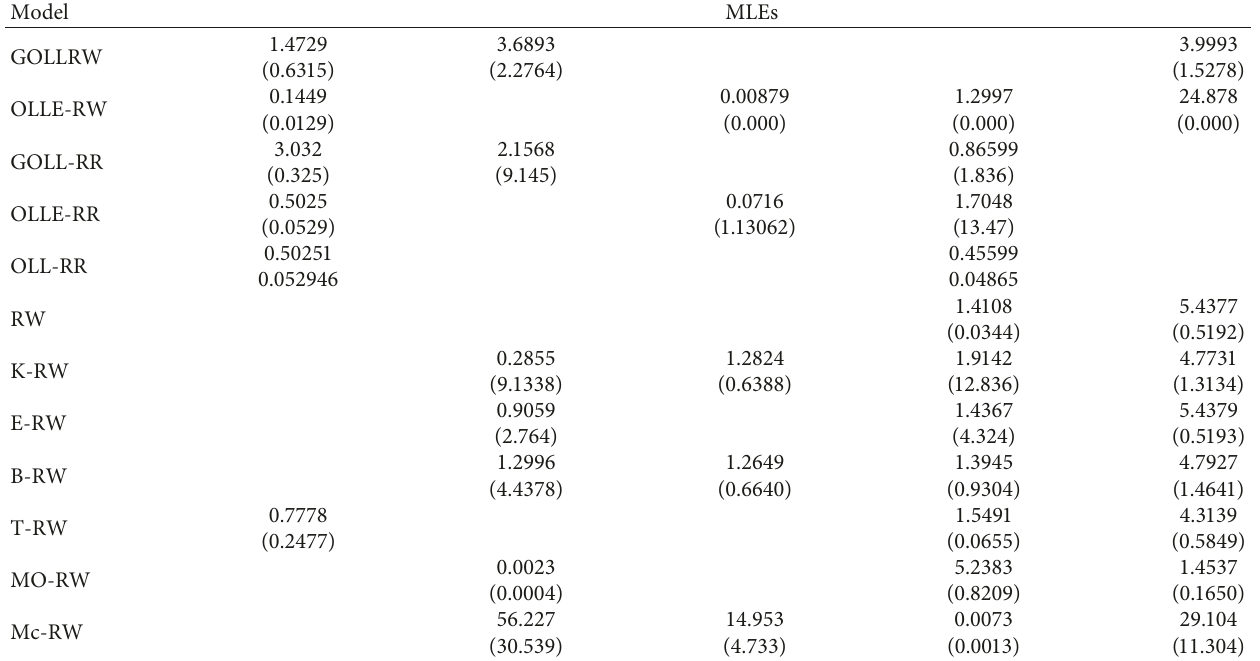
Table 11: MLEs (SEs) for fiber data